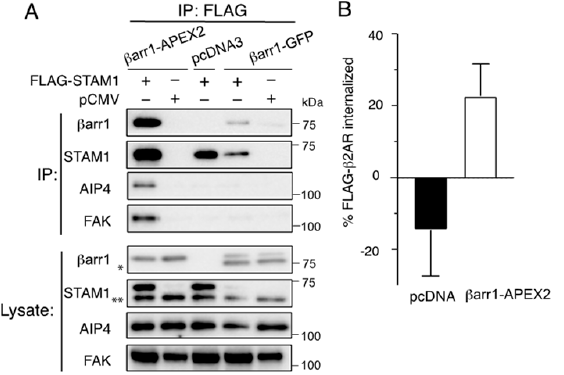
Figure 2. Tagging β arr1 with APEX2 does not interfere with its function. ( A ). Binding of β arr1-APEX2 to known β arr1 binding partners. FLAG immunoprecipitates were prepared from cleared cell lysates of COS-1 cells transiently expressing FLAG-STAM1 or empty vector (pCMV) and β arr1-APEX2, β arr1-GFP or empty vector (pcDNA3). FLAG immunoprecipitates and lysates were analyzed by immunoblotting for the indicated proteins. Shown are representative immunoblots from one of three independent experiments. The single asterisk (*) indicates a degradation product associated with β arr1-GFP. The double asterisks (**) indicate a nonspecific band associated with the antibody against STAM1. FLAG-STAM1 is expressed at low levels when transfected with β arr1-GFP, and not readily visible on the STAM1 immunoblot from lysates on the exposure shown, although present in